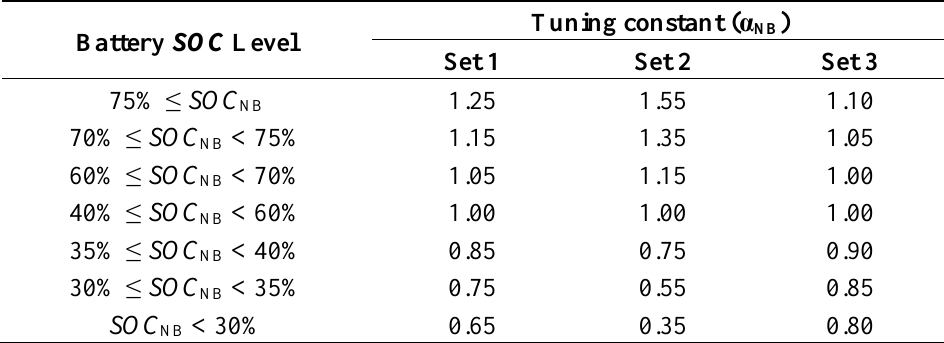
Table 5. NB tuning constant sets used in Case 4.